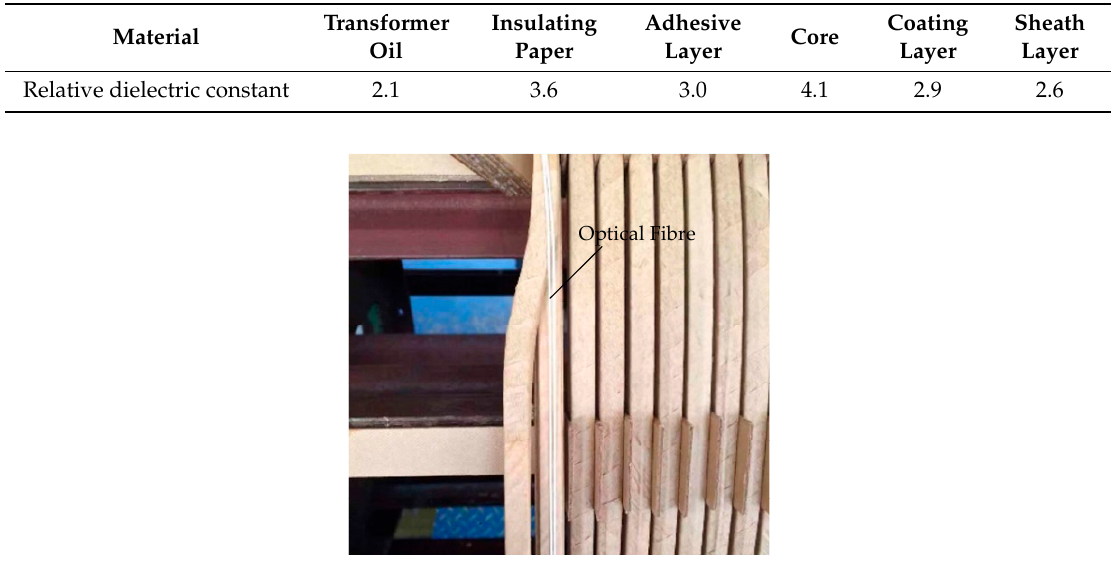
Figure 5. Transposition between cakes.